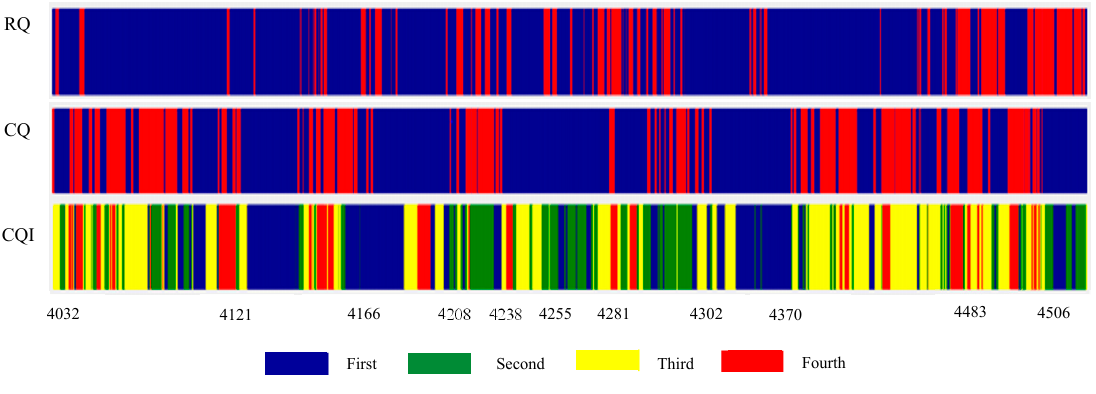
Figure 11. GMM clustering results of well B.